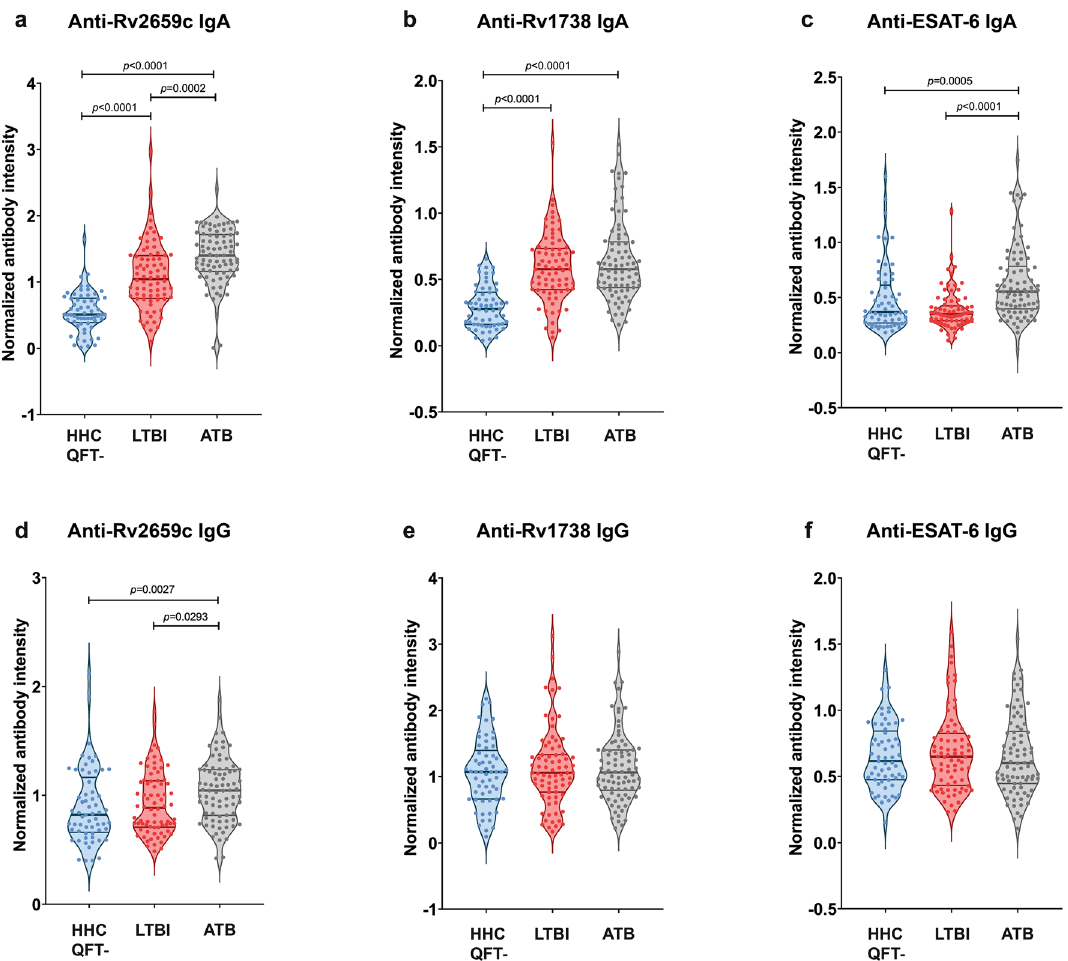
Figure 4. Levels of IgG and IgA antibody responses against proteins Rv2659c, Rv1738 and ESAT-6 by study groups. Quantitation of plasma antibodies in HHC (n = 61), LTBI (n = 76) and ATB (n = 82) subjects against proteins Rv2659c ( a , d ), Rv1738 ( b , e ) and ESAT-6 ( c , f ) was performed by indirect ELISA. Individual antibody- reactivity was represented as the normalized antibody intensity, calculated by the OD values of each sample multiplied by the normalized factor (OD of serum control divided by mean OD values in the same plate). Data are demonstrated in violin plot with median and interquartile range. One-way ANOVA Kruskal–Wallis test following Dunn’s multiple comparison was used for statistical analyses. A p -value < 0.05 was considered statistically significant.